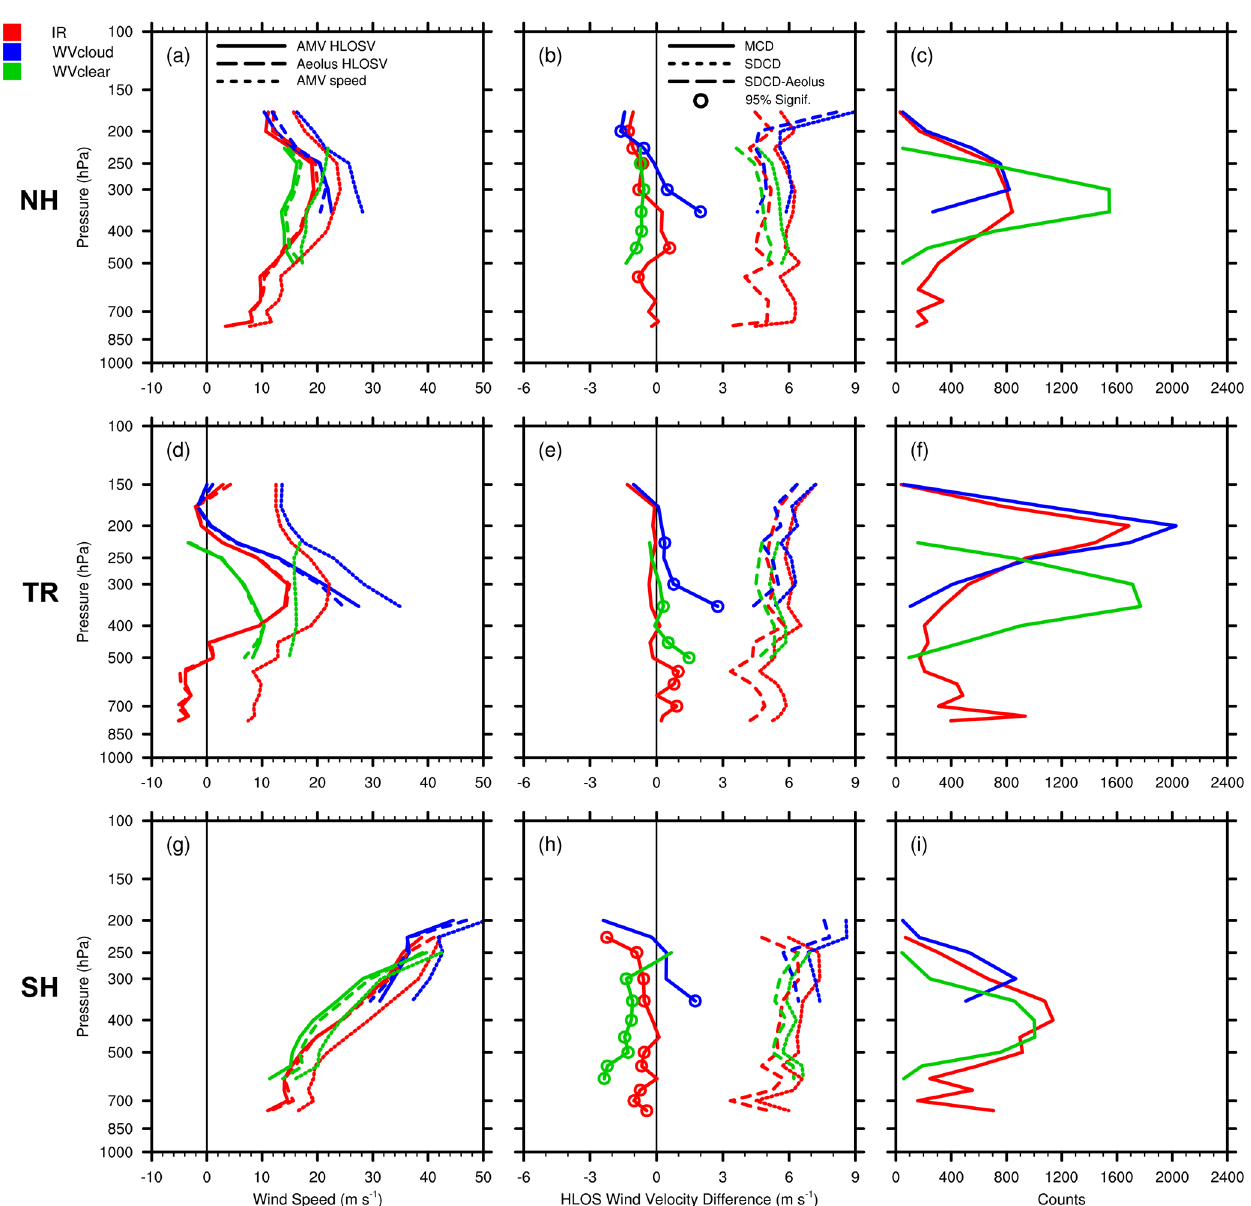
Figure 7. Vertical profiles of co-located GOES-16 AMVs and RAY winds. The top row shows the NH extratropics (30–60 ◦ N), (a) mean AMV HLOSV (solid lines), RAY HLOSV (long dashed lines), mean AMV wind speed (short dashed lines; ms − 1 ), (b) MCDs (solid), SDCDs (short dashed) and AMV HLOSV errors, as represented by SDCD–Aeolus L2B uncertainty (long dashed; ms − 1 ), and (c) co-location counts. Panels (d–f) are as in panels (a–c) but for the tropics (30 ◦ S to 30 ◦ N), and panels (g–i) are as in panels (a–c) but for the SH extratropics (30–60 ◦ S). Colors denote the AMV type, including IR (red), WVcloud (blue), and WVclear (green). Colored open circles indicate levels where MCDs are statistically significant at the 95% level ( p value < 0.05), using the paired Student’s t test. Vertical zero lines are displayed in the left and center panels in black. Levels with observation counts > 25 are